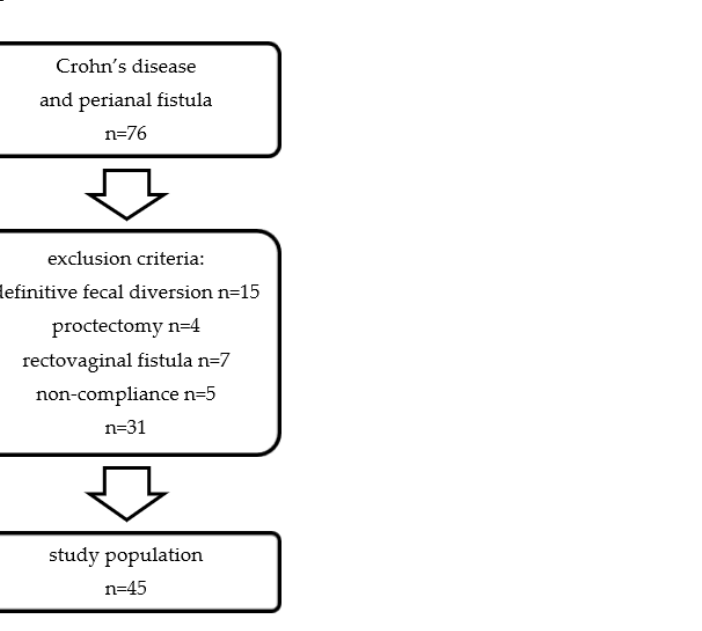
Figure 1. Flow diagram of study cohort in patients with CD and perianal fistula.